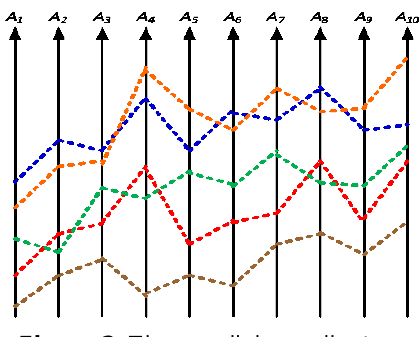
Table 2. Wind speed in real number mapped onto wind force in natural number (according to